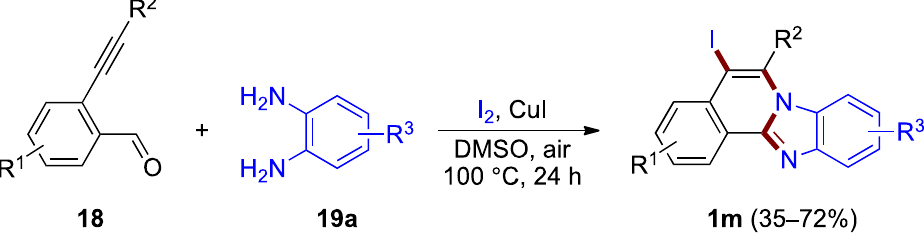
Figure 16. Synthesis of 5-iodobenzimidazo[2,1- a ]isoquinolines 1m .